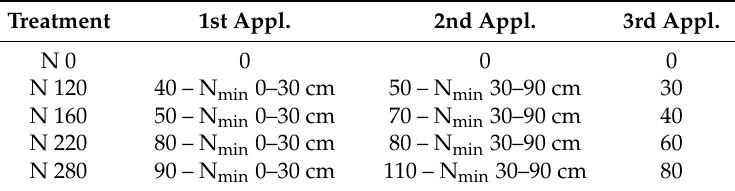
Table 2. Target values of N availability (kg N ha − 1 ) of the N response trials. N fertilizer was applied at post-winter vegetation start (1st appl.), begin of booting (2nd appl.) and at flag leaf emergence (3rd appl.). N fertilizer application at the 1st and 2nd application date considered site-specific availability